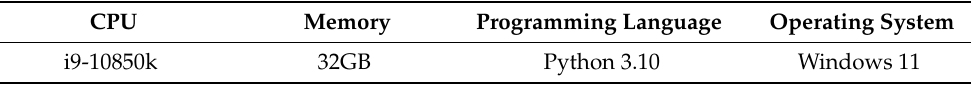
Table 1. Simulation Interface Components.